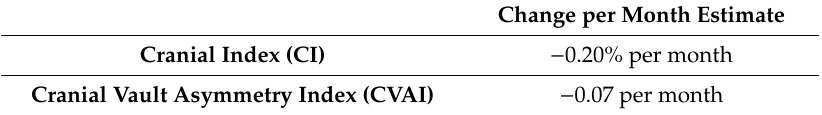
Table 5. Change per month estimates for CI and CVAI across 500 subjects of varying